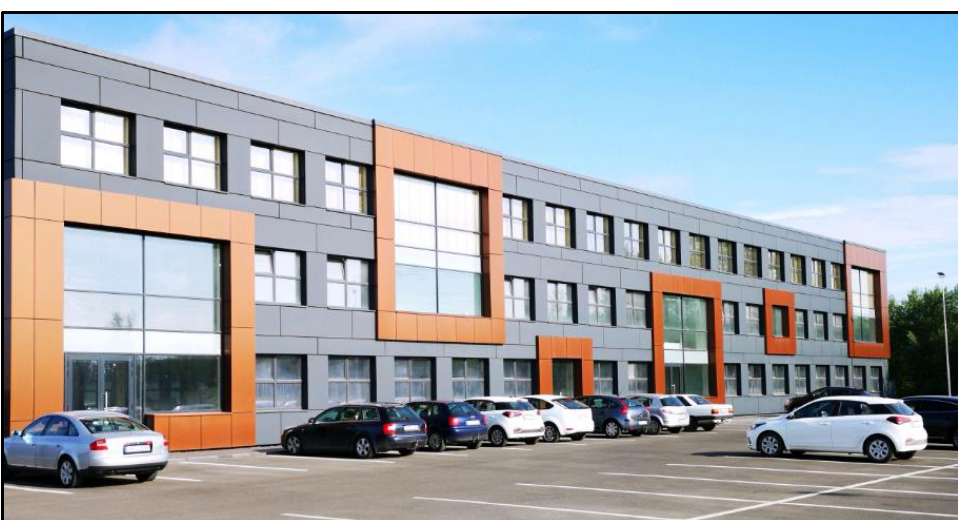
Figure 2. Building after reconstruction (“A” building) .